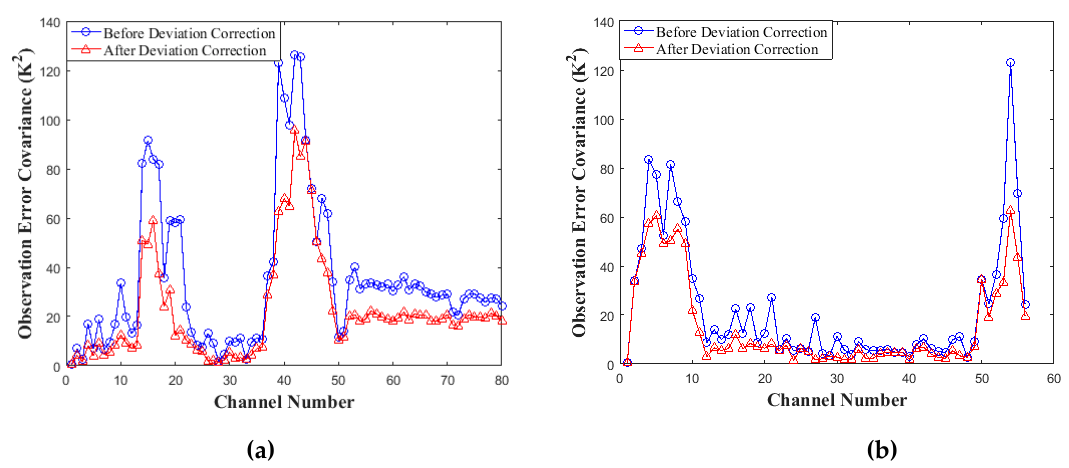
Figure 6. ( a ) The effect of the error correction on temperature and ( b ) the effect of the error correction on humidity.